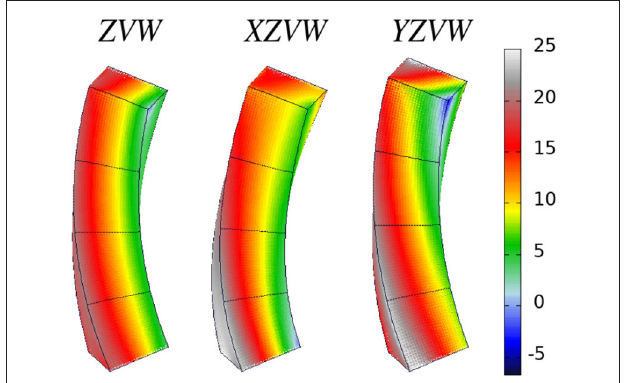
FIGURE A4 | A square prism beam, with sides L = 25, and height H = 101, loaded in tension and bending ( ZV ), with added torsion ( ZVW ) and shear ( XZVW and YZVW